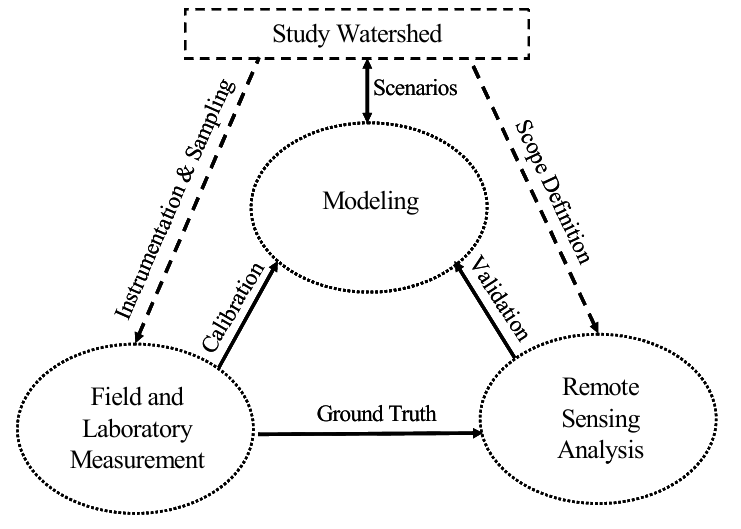
Figure 1. Schematic showing the ecohydrologic approach.